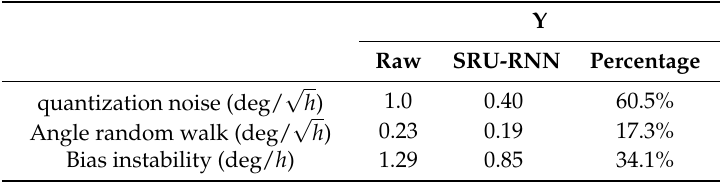
Figure 10. De-noised and raw signals comparison for Y-axis gyroscope. Table 5. Parameters of Y-axis gyroscope